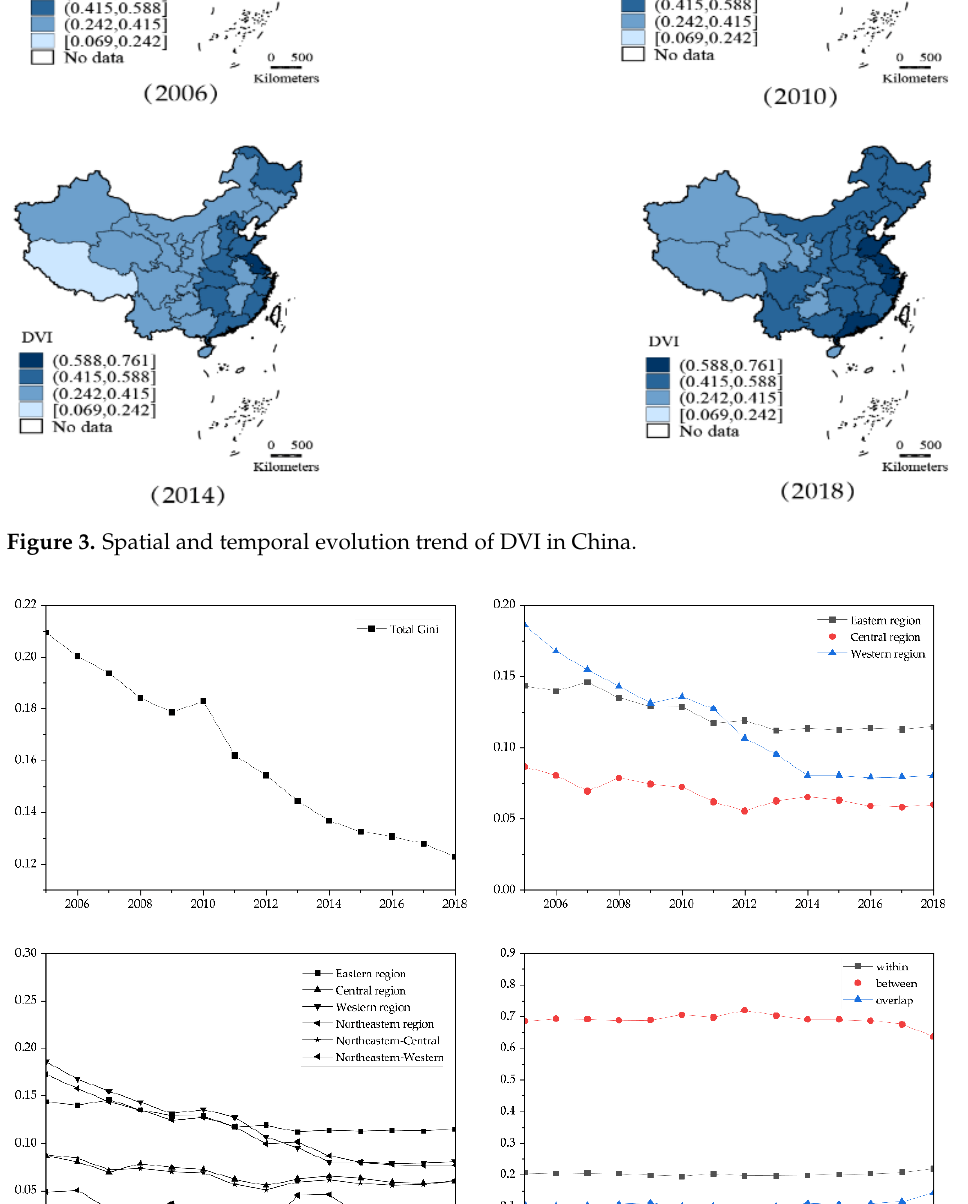
Figure 4. Gini coefficient variation and differential contribution rate of DVI in China.